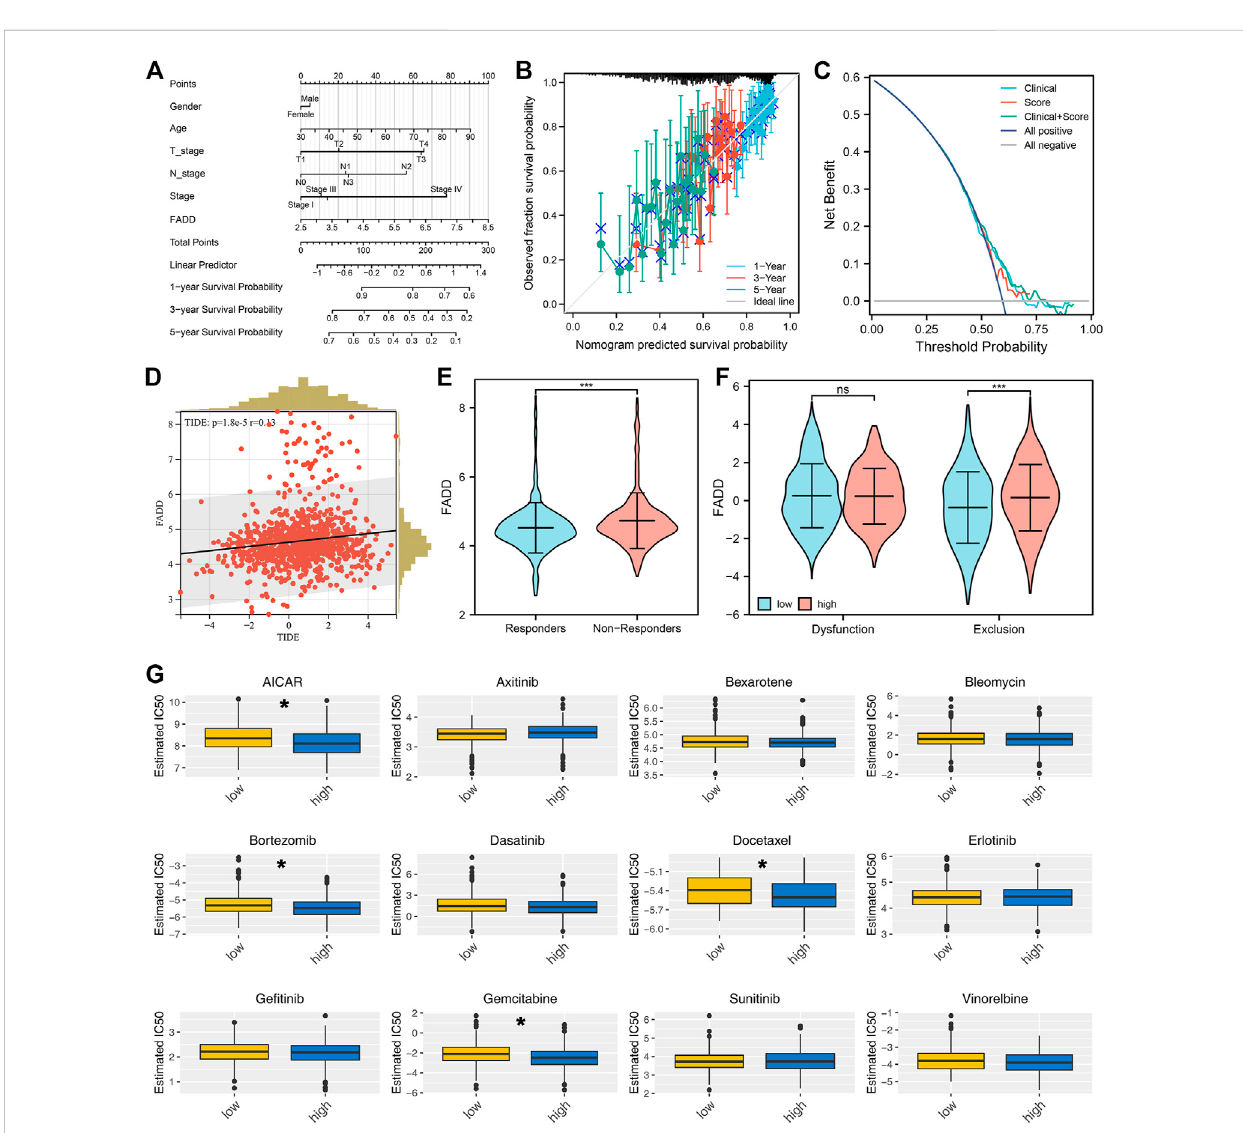
FIGURE 5 Immunotherapy and drug sensitivity of FADD. Notes: (A) A nomogram plot was constructed based on clinical features and FADD; (B) Calibration curves; (C) DCA curves; (D) Correlation between TIDE score and FADD; (E) The expression level of FADD in immunotherapy responders and non- responders; (F) The immune dysfunction and exclusion in high- and low-FADD expression patients; (G) The difference in drug sensitivity among high- and low-FADD expression